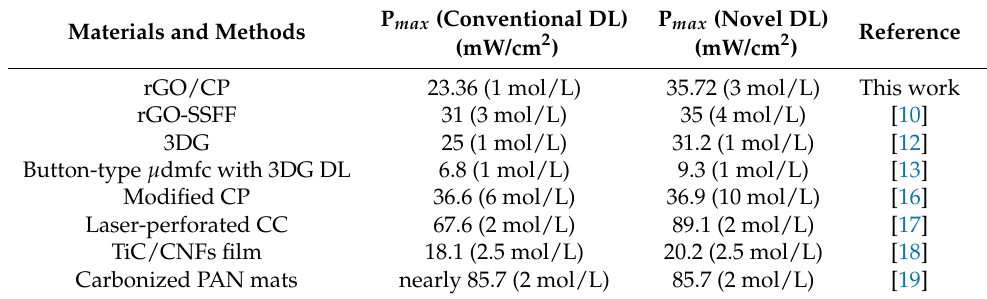
Table 2. Comparison with state-of-the-art works in diffusion layer design.